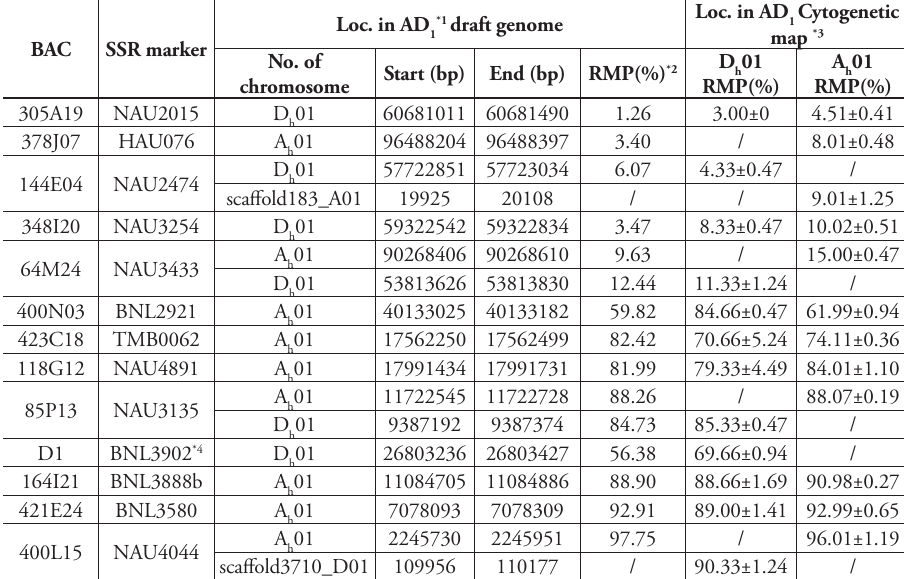
Table 3. Physical locations of FISH-mapped BACs in G. hirsutum draft genome assembly and cytoge- netic